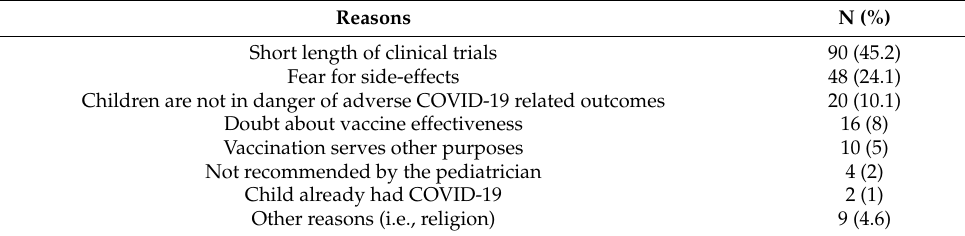
Table 3. Primary reason for not intending to vaccinate children against COVID-19 (N = 199).